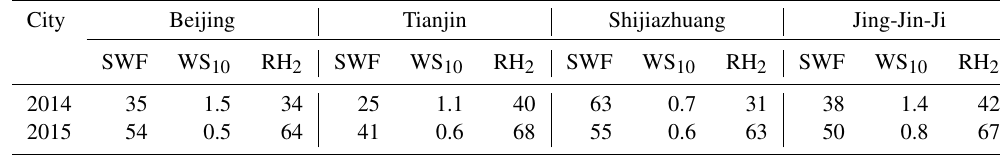
Table 1. Comparison of SWF (%), WS 10 (ms − 1 ) , and RH 2 (%) for December of 2015 and 2014.